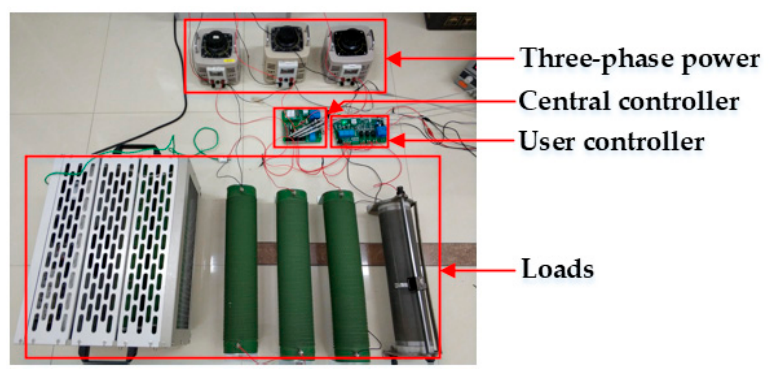
Figure 14. Experimental circuit diagram.